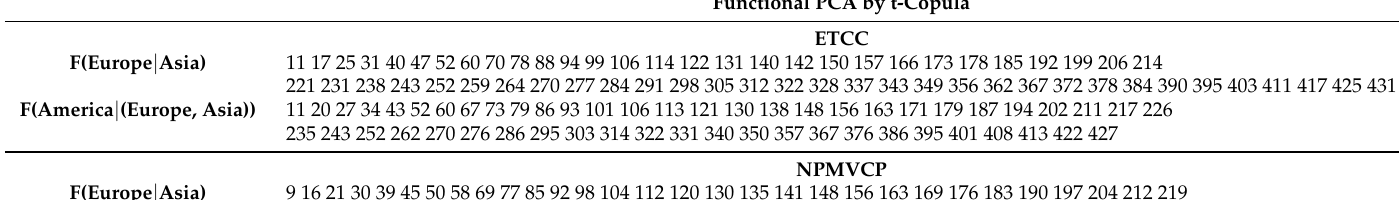
Table 18. Change point detection by ETCC and NPMVCP of FPCA and copulas with real exchange currency data (1/3/2013 to 10/6/2014). F(Europe |